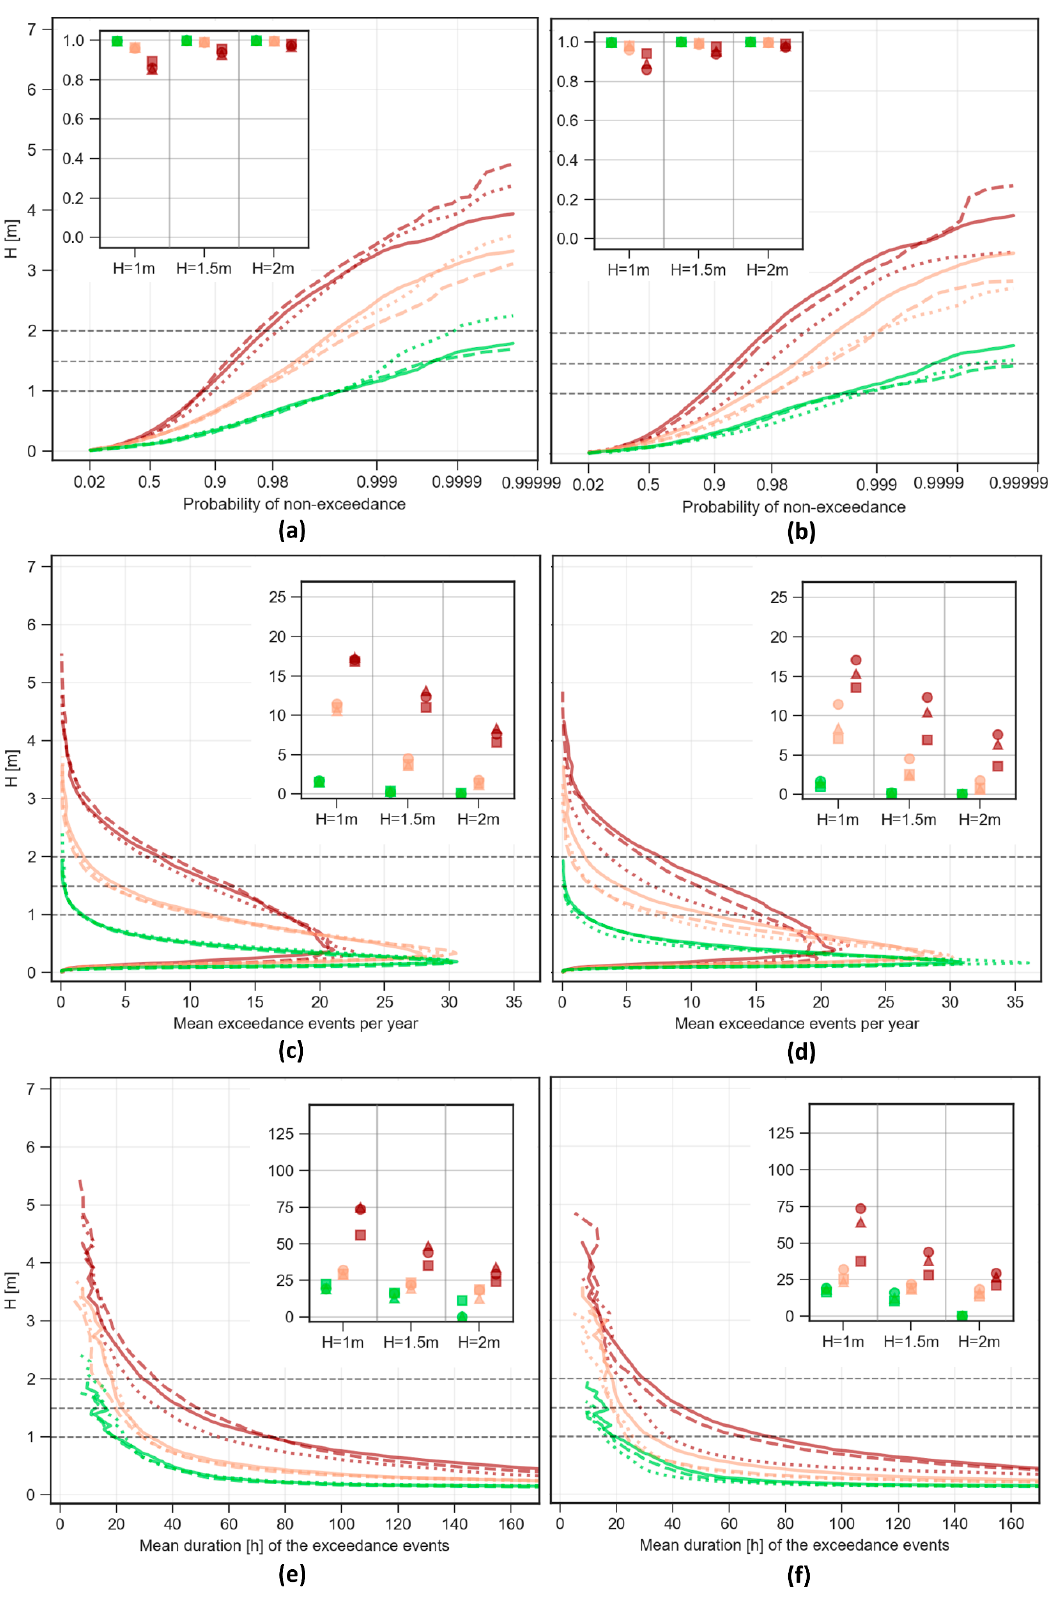
Figure A7. Comparative of operability indicators for Type 3 AOIs, including a detail of a threshold overcoming analysis for the complete sets of: ( a ) PROB , short-term; ( b ) PROB , long-term; ( c ) N , short- term; ( d ) N , long-term; ( e ) T , short-term; ( f ) T , long-term.